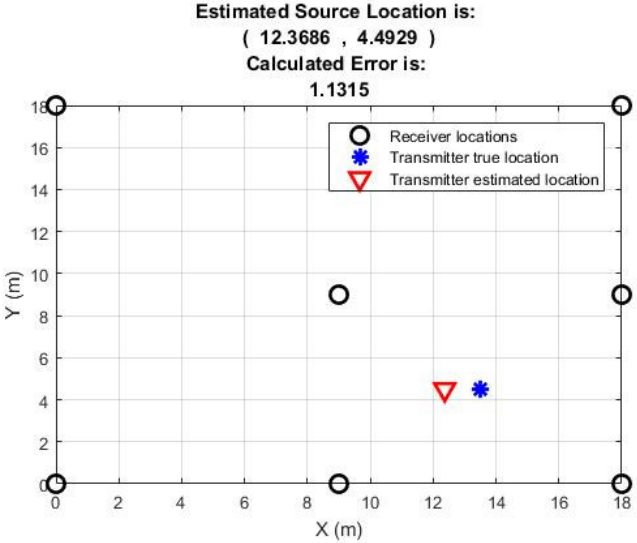
Figure 9. Position 1 result of the estimated source location with seven receiving nodes.